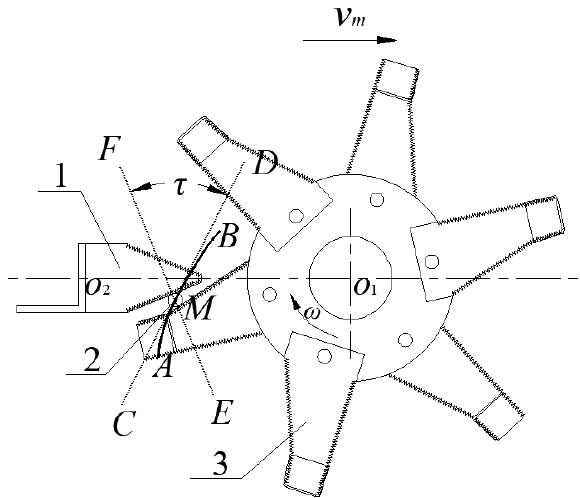
Fig. 8. Schematic diagram of axial moving and fixed cutter